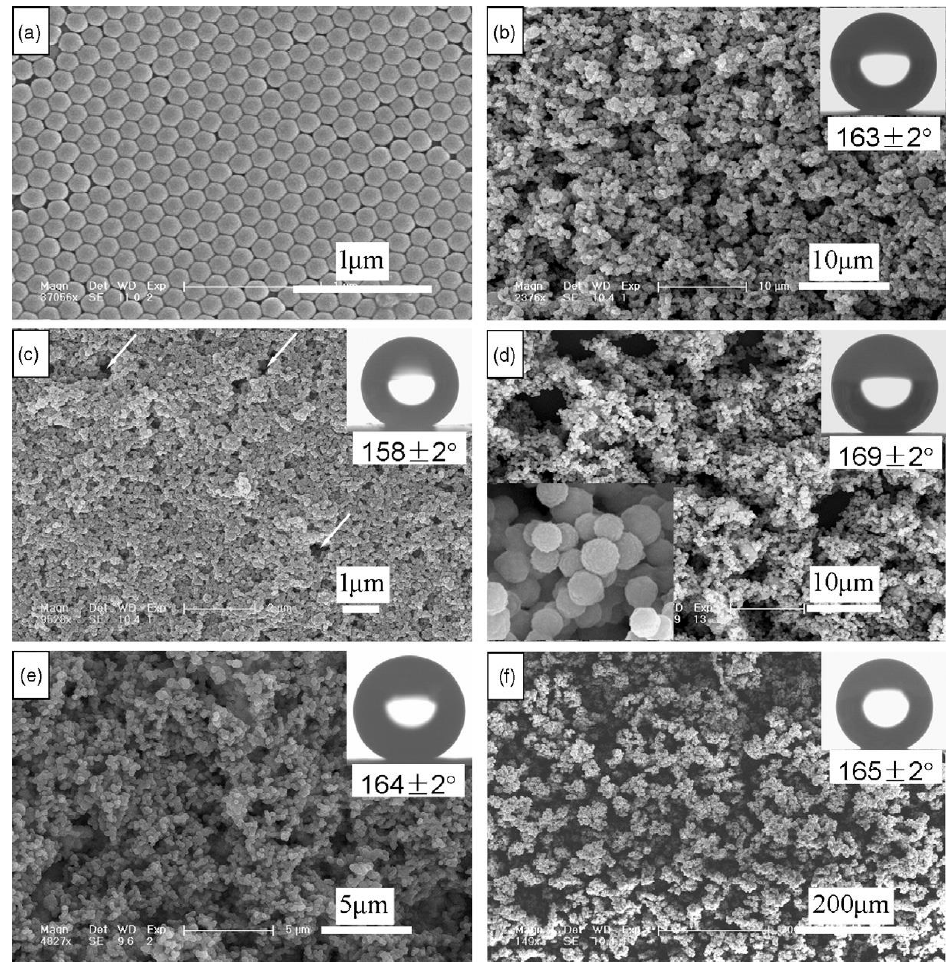
Figure 14. FESEM micrographs of ( a ) the unmodified silica nanoparticles with diameters of 167 nm and the vinyl-modified silica nanoparticles with different diameters: ( b ) 85 nm, ( c ) 167 nm, ( d ) 360 nm, ( e ) 453 nm, and ( f ) 1600 nm. The insets on the top right corners are the corresponding profiles of water drops on the surfaces and the water contact angles. The inset on the bottom left of ( e ) shows the enlarged particles. Reproduced with permission from [68].